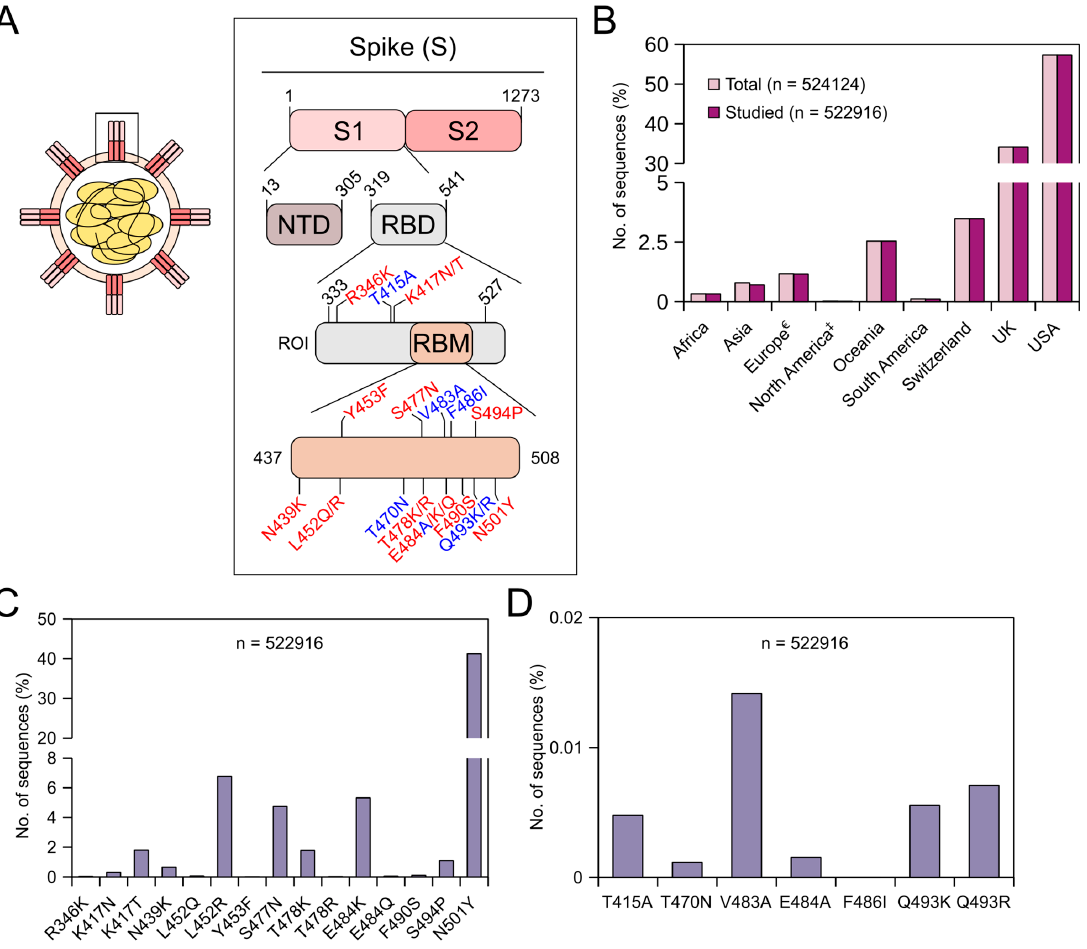
Figure 1. Global prevalence of adaptive and prolonged infections’ mutations in the receptor-binding domain (RBD) of the SARS-CoV-2 spike (S) protein until 29 May 2021. ( A ) SARS-CoV-2 virion (left) and schematics of the S protein (right). The